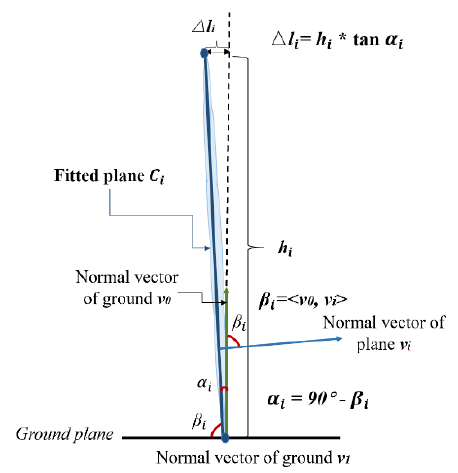
Figure 6. Vertical deviation computation.